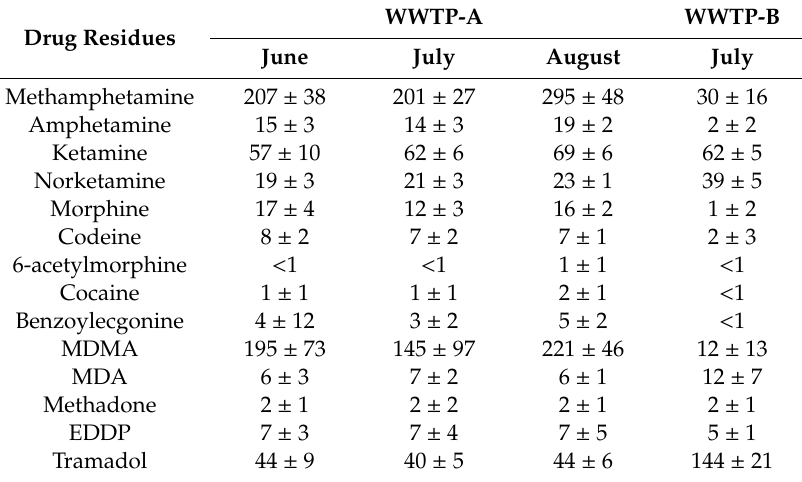
Table 2. Mean influent loads (mg / 1000 inh / d) of drug residues in WWTP-A and